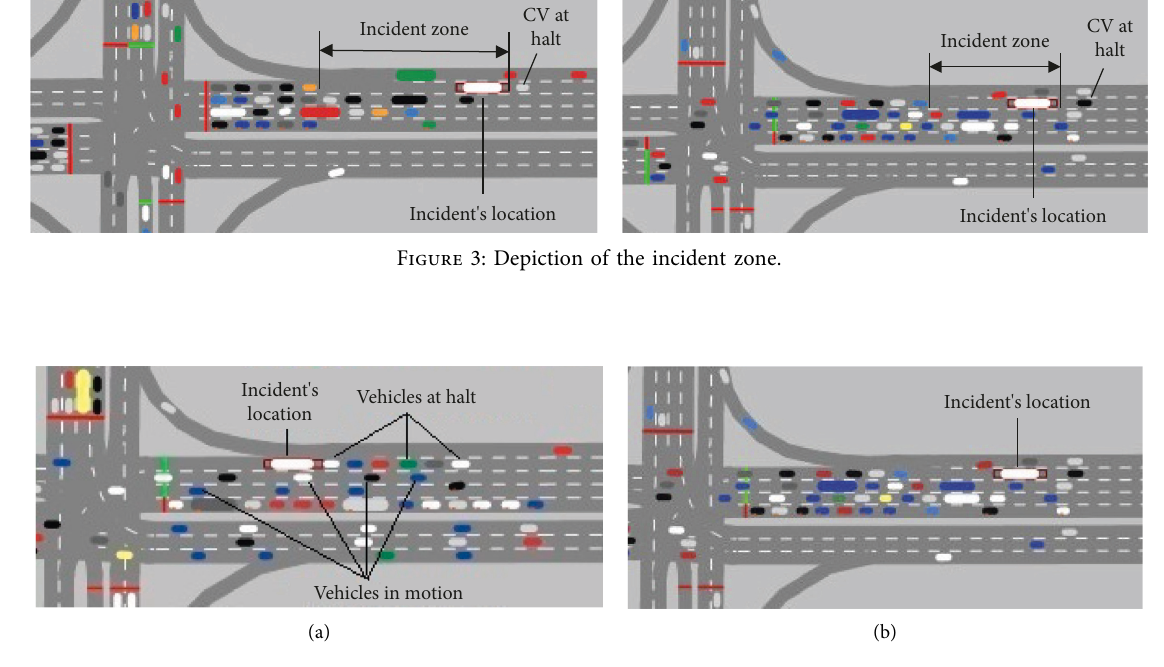
Figure 4: Traffic flow depiction during the occurrence of an incident.